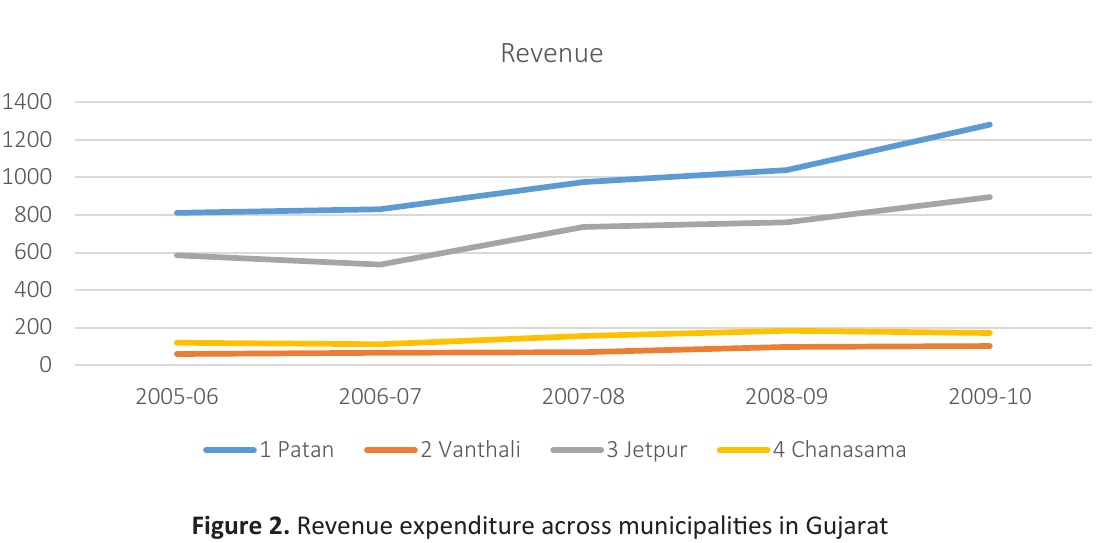
Source: Table A2 of the Appendix.